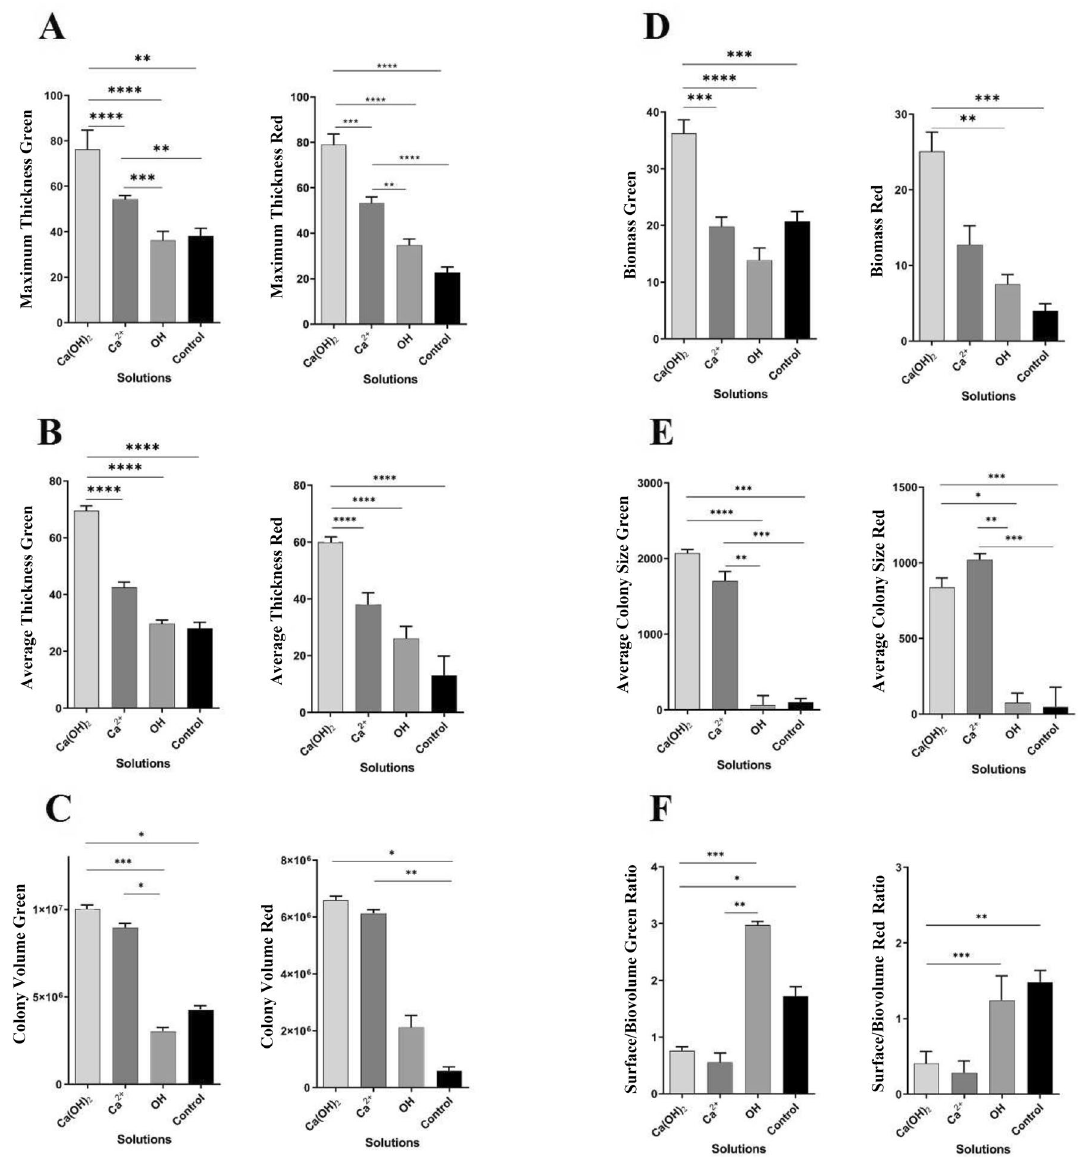
token: *, 0.05; **, 0.01; ***, 0.001; ****, 0.0001. No significant results were not